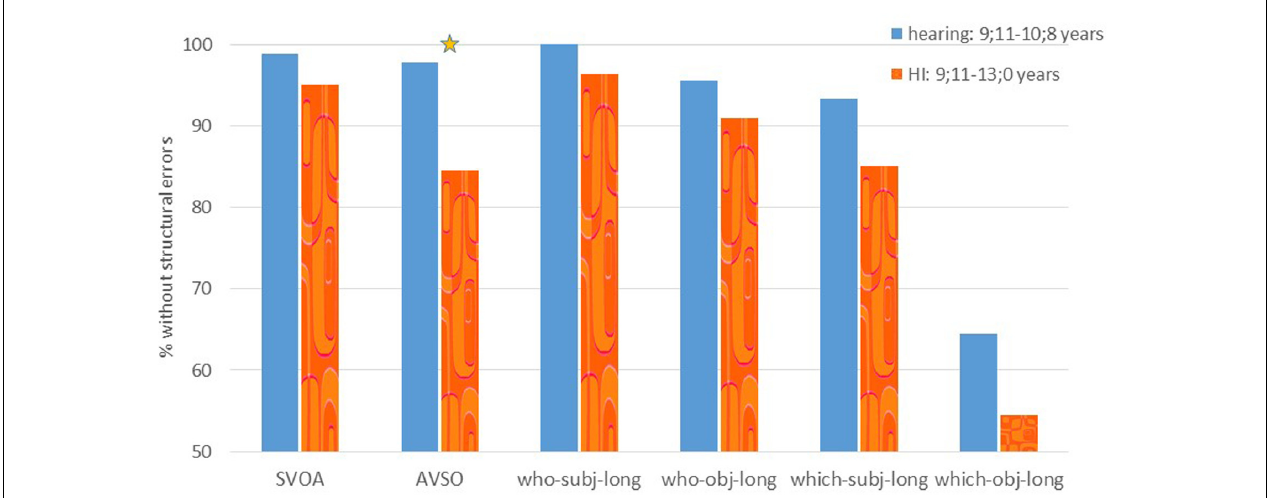
FIGURE 6 | Experiment 4: % of sentences repeated without structural errors. The star indicates a significant difference between the groups.